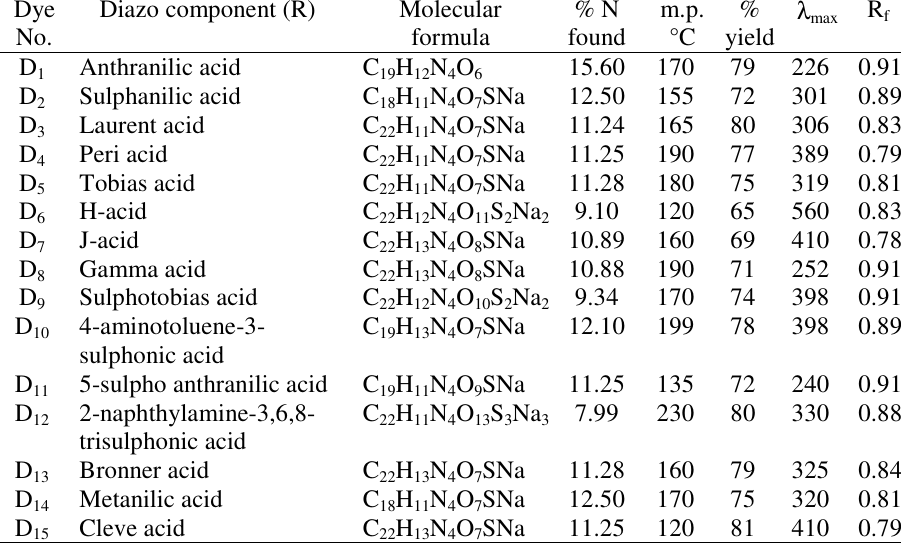
Table 1. Physical data for acid dyes